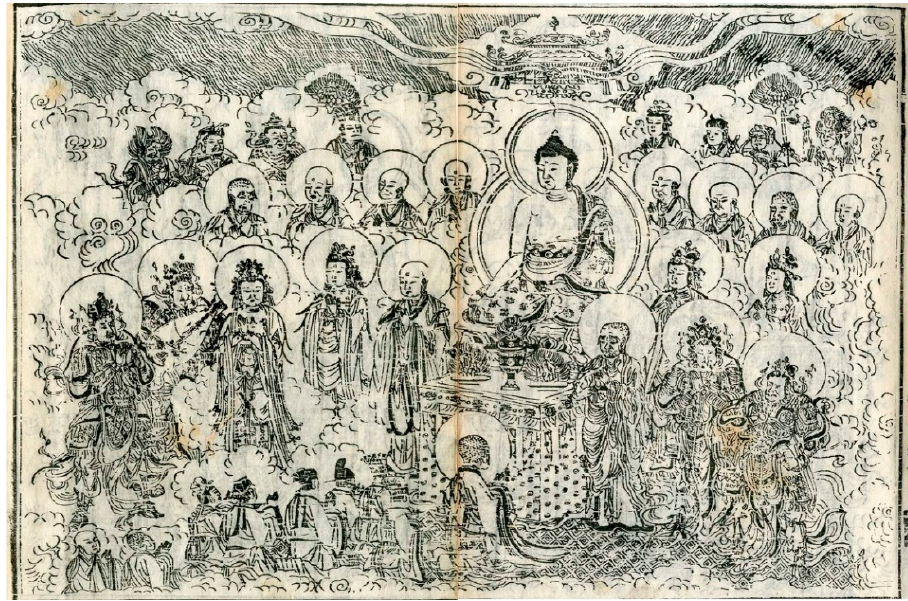
Figure 12. Lotus Sutra, published at Songgwangsa Temple, Joseon (1607), 26.7 × 19.5 cm, Dongguk University Library. Photo by the author.